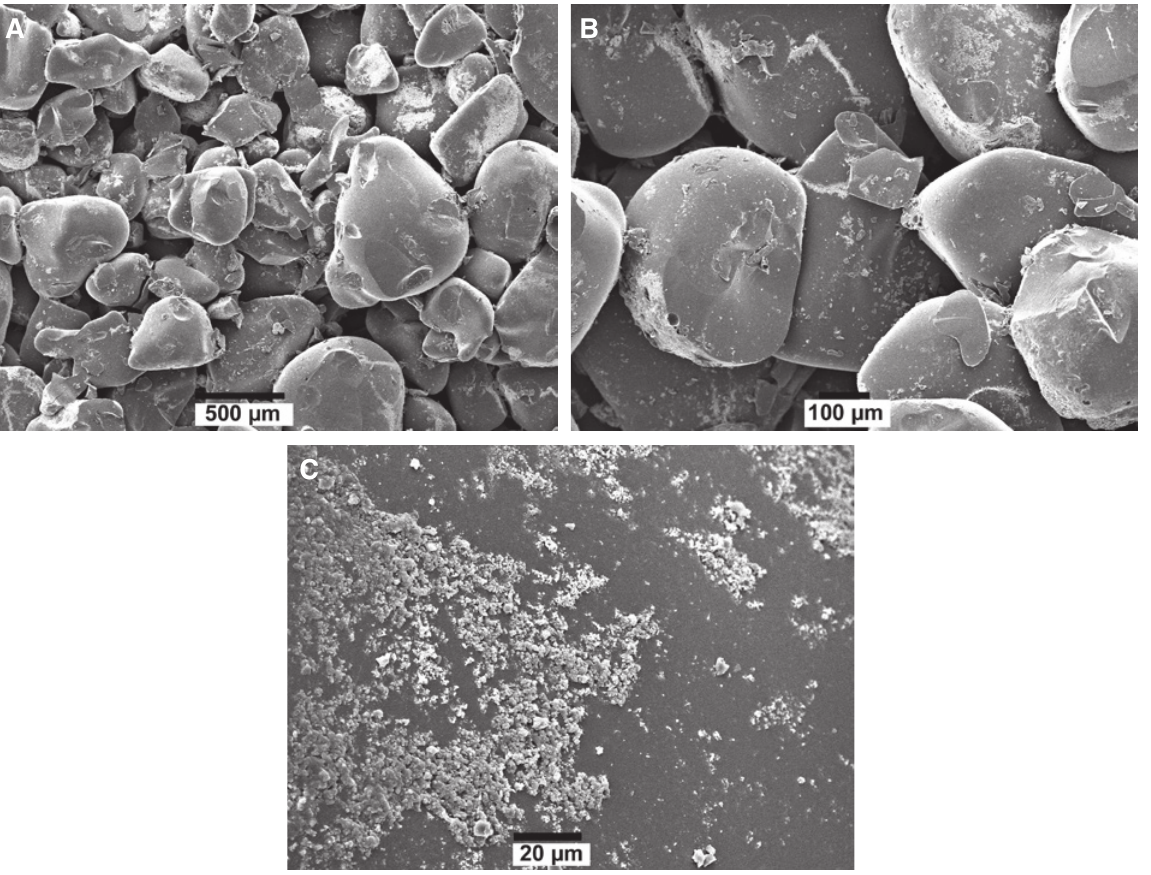
sintered at 800 ° C for 20 min obtained at different magnifications, (A) 2